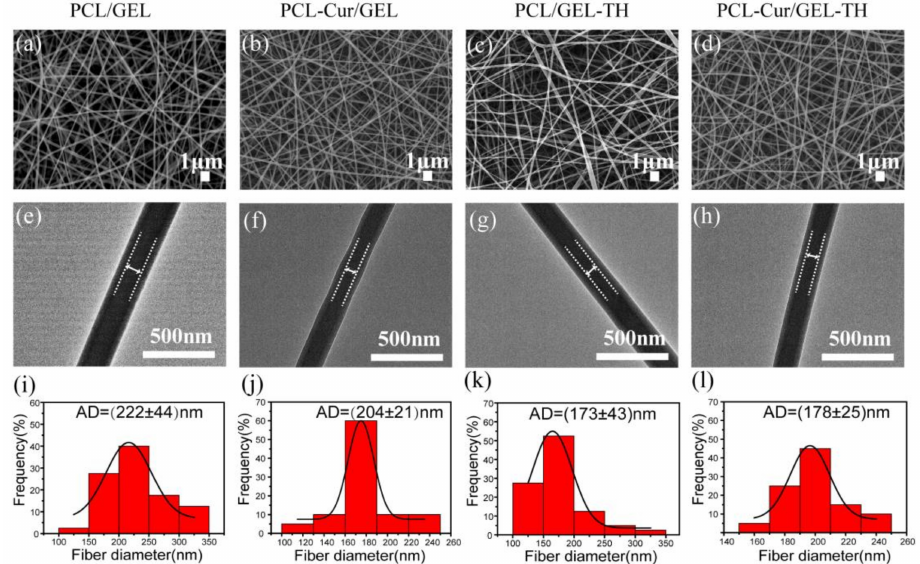
Figure 1. ( a – d ) SEM, ( e – h ) TEM images and ( i – l ) the corresponding diameter distribution of different coaxial nanofibers. The white dash line in ( e – h ) indicates the border between the PCL core and GEL